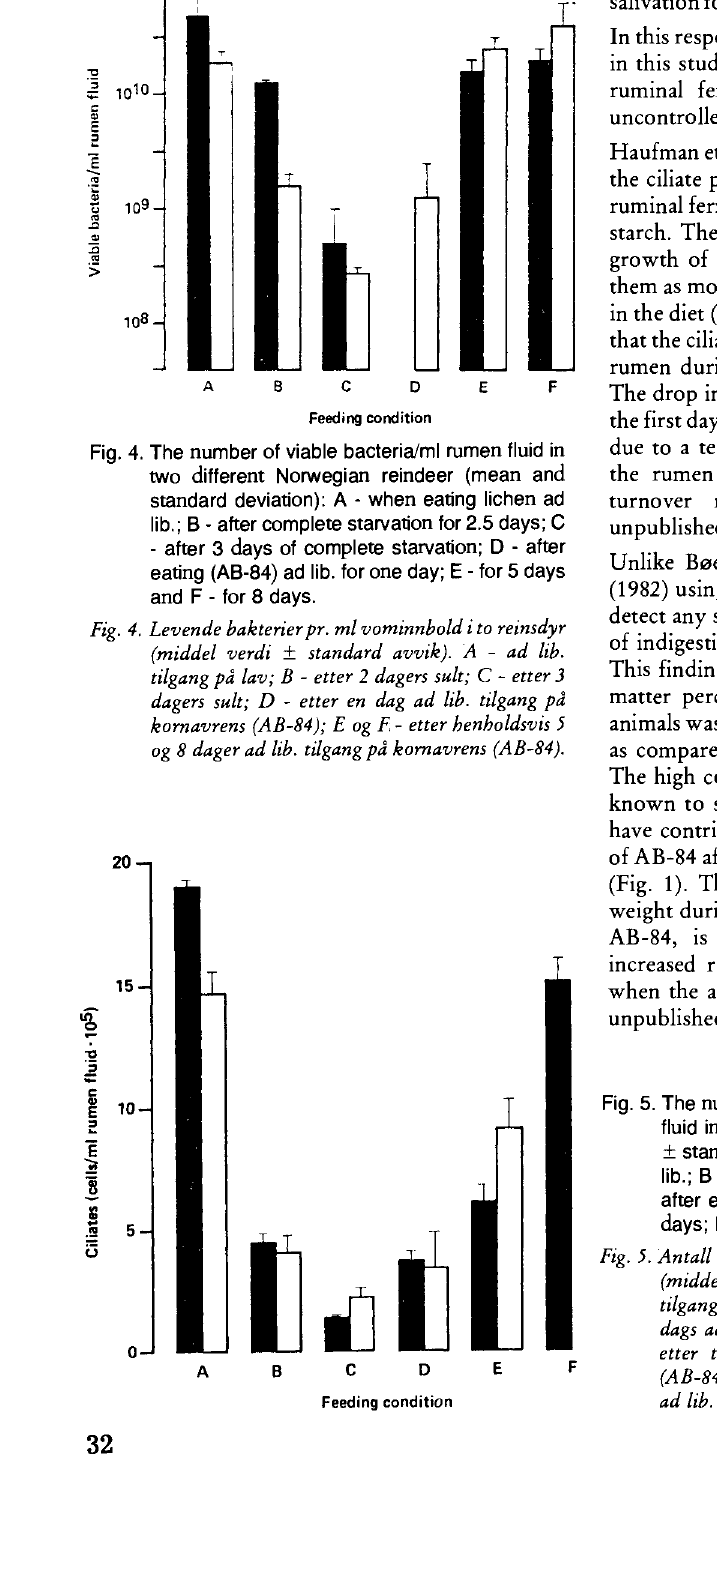
Fig. 5. The number of rumen ciliate protozoa/ml rumen fluid in two different Norwegian reindeer (mean ± standard deviation). A - when eating lichen ad lib.; B - after 3 days of complete starvation; C - after eating (AB-84) ad lib. for 1 day; D - for 2 days; E - for 5 days; and F - for 8 days. Fig. 5. Antall ciliater pr. ml vominnhold i to reinsdyr (middelverdi ± standard avvik). A - ved ad lib. tilgang på lav; B - etter 3 dagers sult; C - etter en dags ad lib. tilgang på kornavrens (AB-84); D - etter to dagers ad lib. tilgang på kornavrens (AB-84); E og F - etter henholdsvis 5 og 8 dager ad lib. tilgang på kornavrens